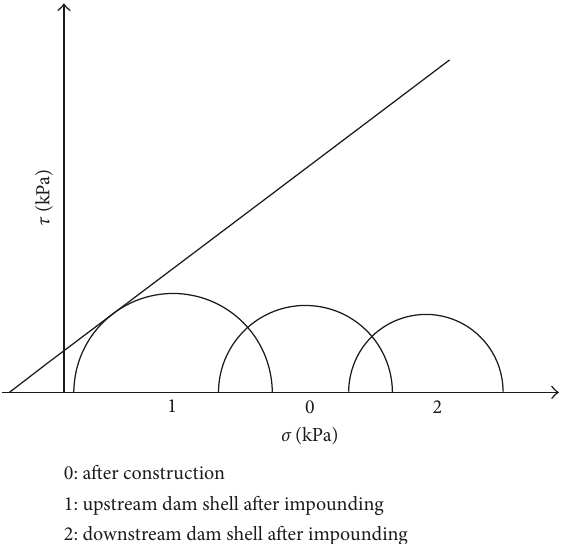
Figure 1: Stress circle change caused by impounding [1].